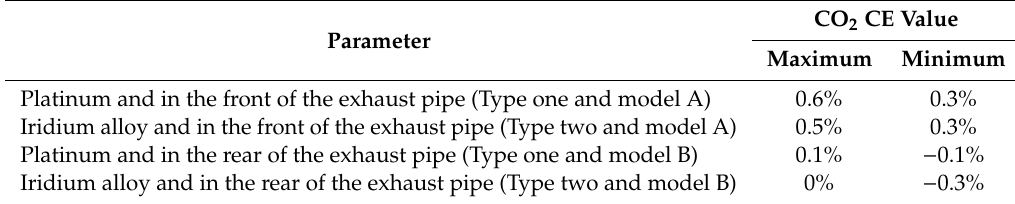
Figure 26. The CO 2 CE at control voltage 5 V. Table 8. The maximum and minimum values of CO 2 conversion efficiency at control voltage 5 V.